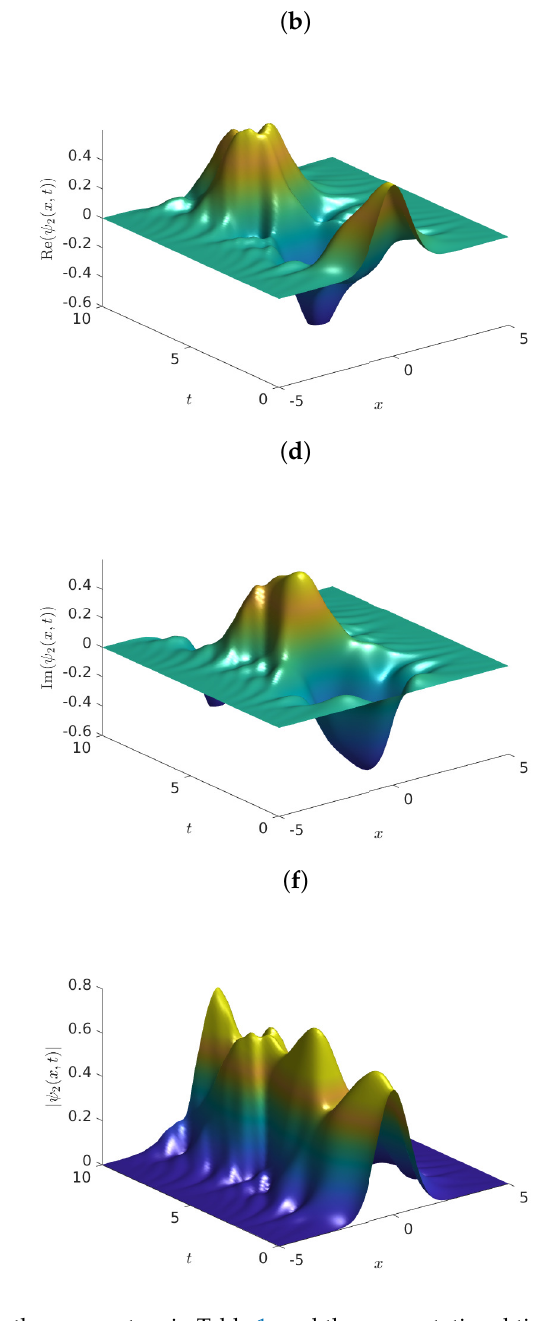
Figure 4. Approximate solutions for the problem (4) using the parameters in Table 1, and the computational time-steps h = 0.1 and τ = 0.05 for the finite-difference method (36). We used V ( x ) = 1 x 2 , and initial data φ 1 ( x ) = φ 2 ( x ) = 2 1 √ exp ( − x 2 ) . The graphs provide the behavior of ( a ) Re ψ 1 , ( b ) Re ψ 2 , ( c ) Im ψ 1 , ( d ) Im ψ 2 , ( e ) | ψ 1 | , and ( f ) | ψ 2 | , versus π ( x , t ) . In these simulations, we used α = 1.9 and α = 2 1